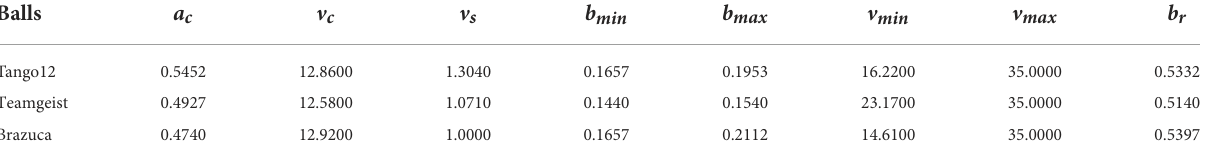
TABLE 2 The fitting coefficients of the drag coefficient function (Kiratidis and Leinweber, 2018). Balls